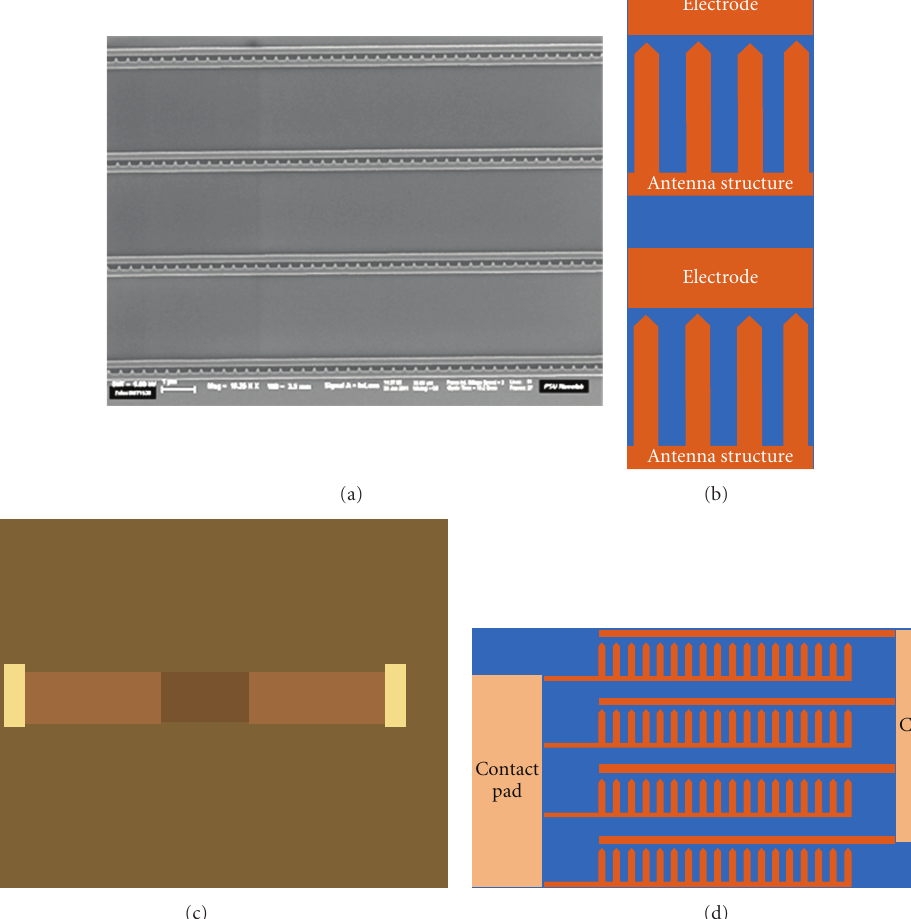
Figure 19: Fabricated rectenna device is shown on the left and a schematic diagram is on the right showing (a) top view SEM image (b) schematic of same; (c) optical image of device (darkerspacing between electrodes b) top view of same and (c) an array of rectennas connected to contact